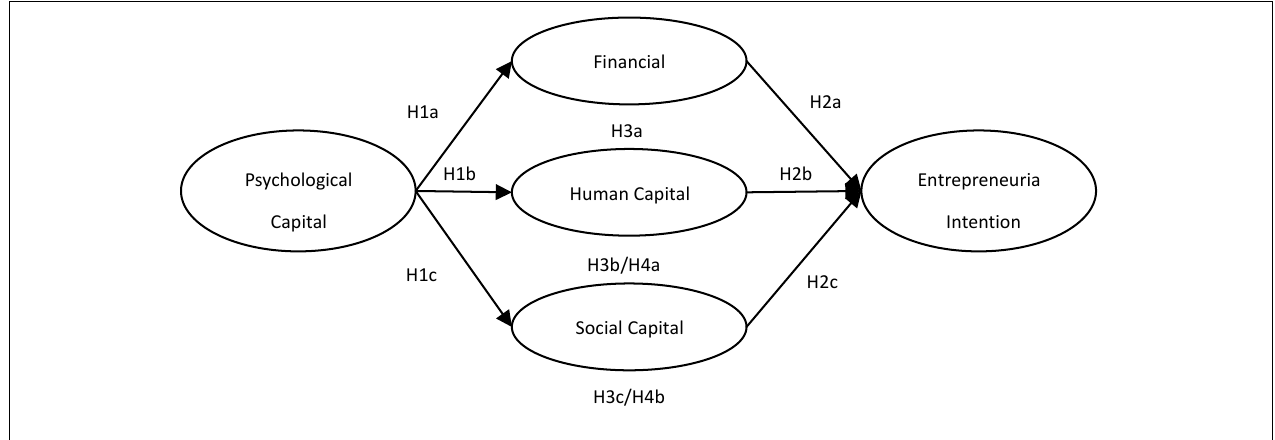
FIGURE 1 | The hypothesized model.